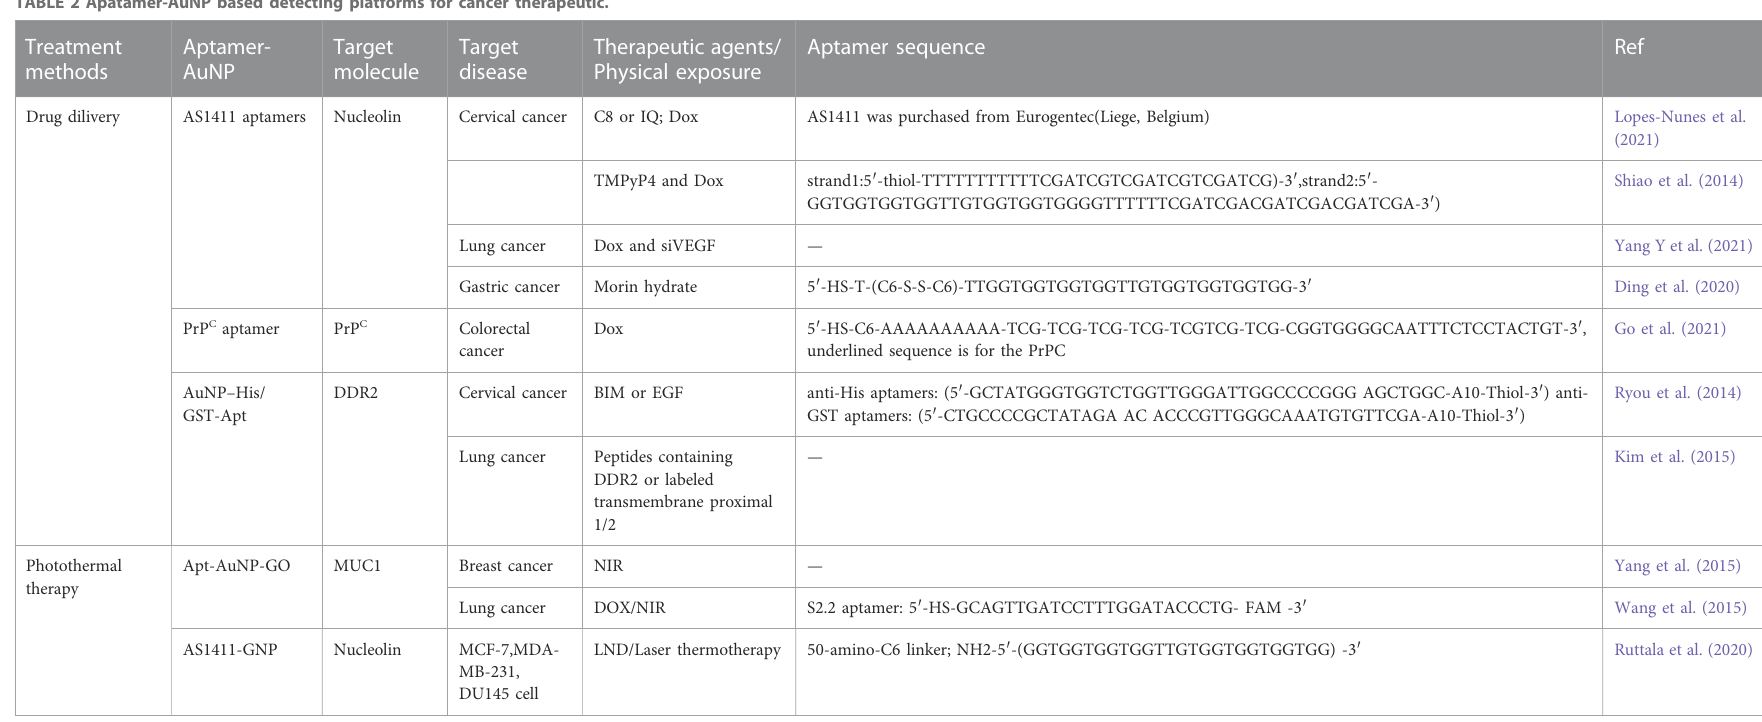
TABLE 2 Apatamer-AuNP based detecting platforms for cancer